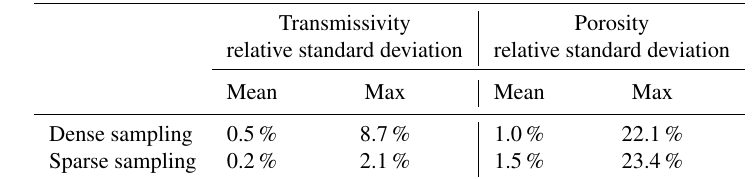
Table 3. Parameter variability between solutions in each batch.